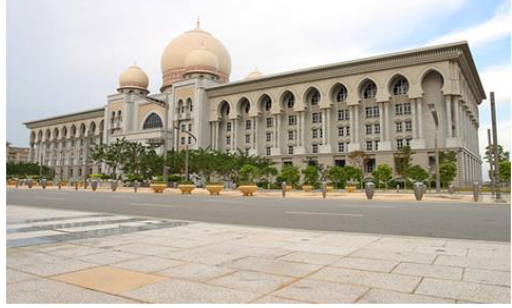
Figure 3. Palace of Justice building